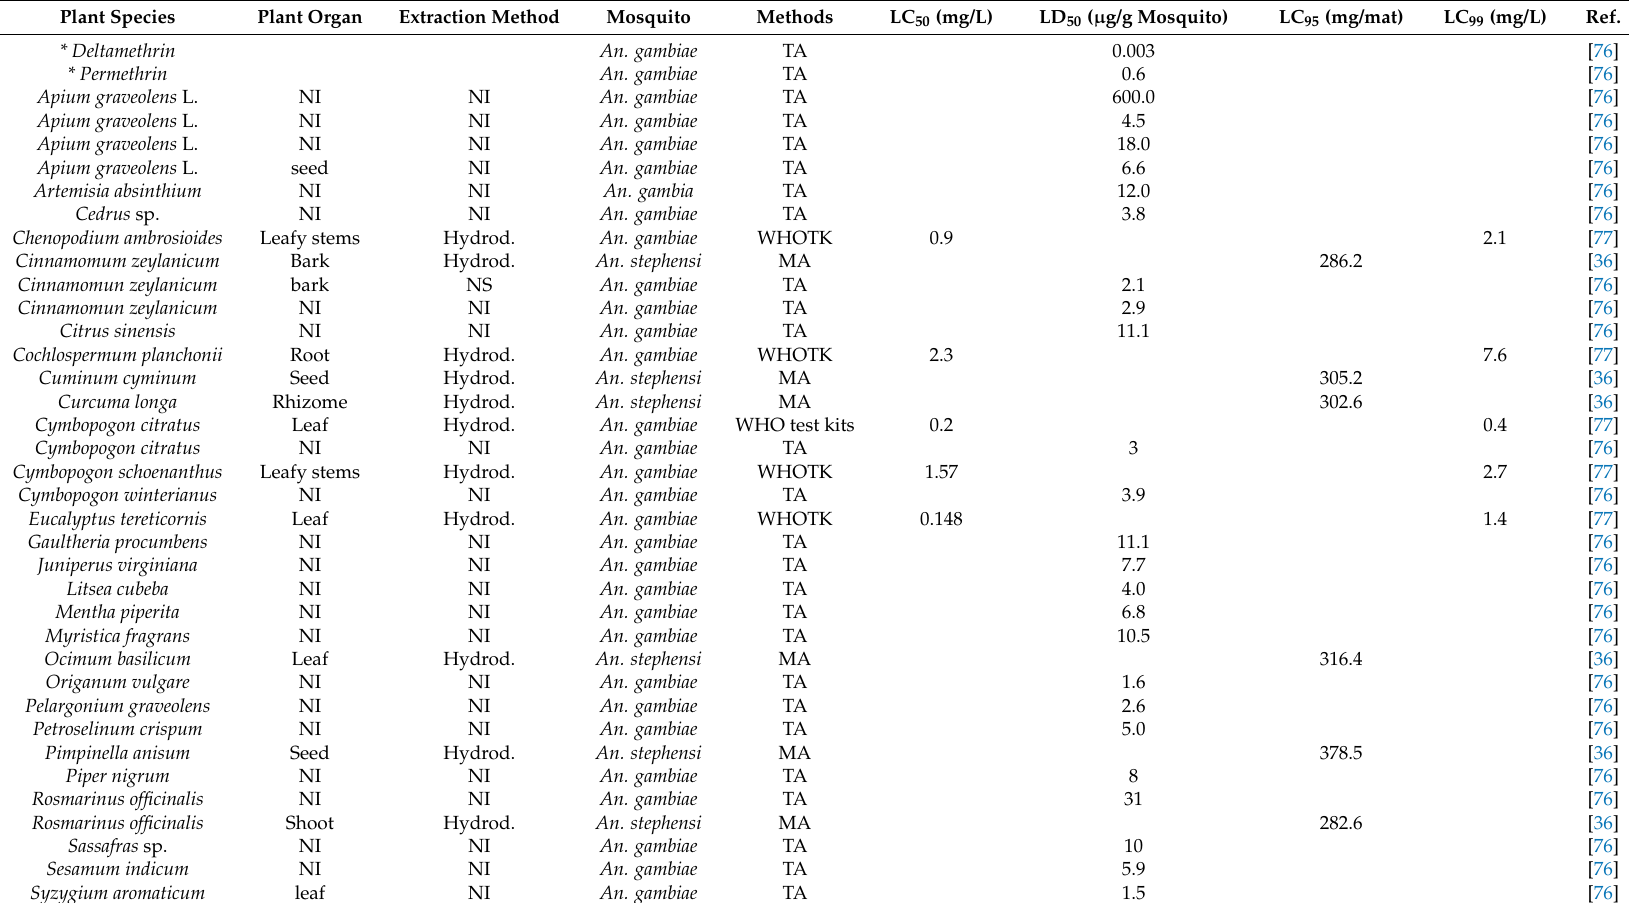
Table 4. Essential oils’ toxicity against Anopheles sp.